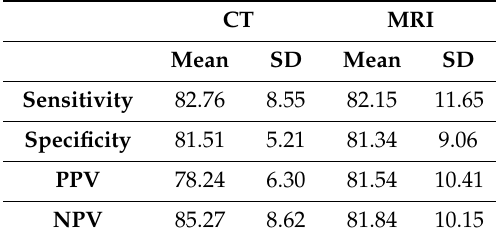
Table 1. Mean and standard deviation (SD) of segment-based sensitivity, specificity, positive predictive values (PPV) and negative predictive values (NPV) for CT and MRI